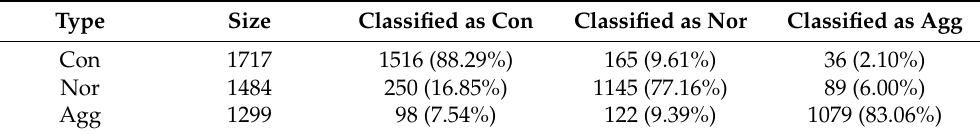
Table 2. Confusion matrix for validation dataset when velocity, geo-information, time, fgx, fgy, and fgz are included.